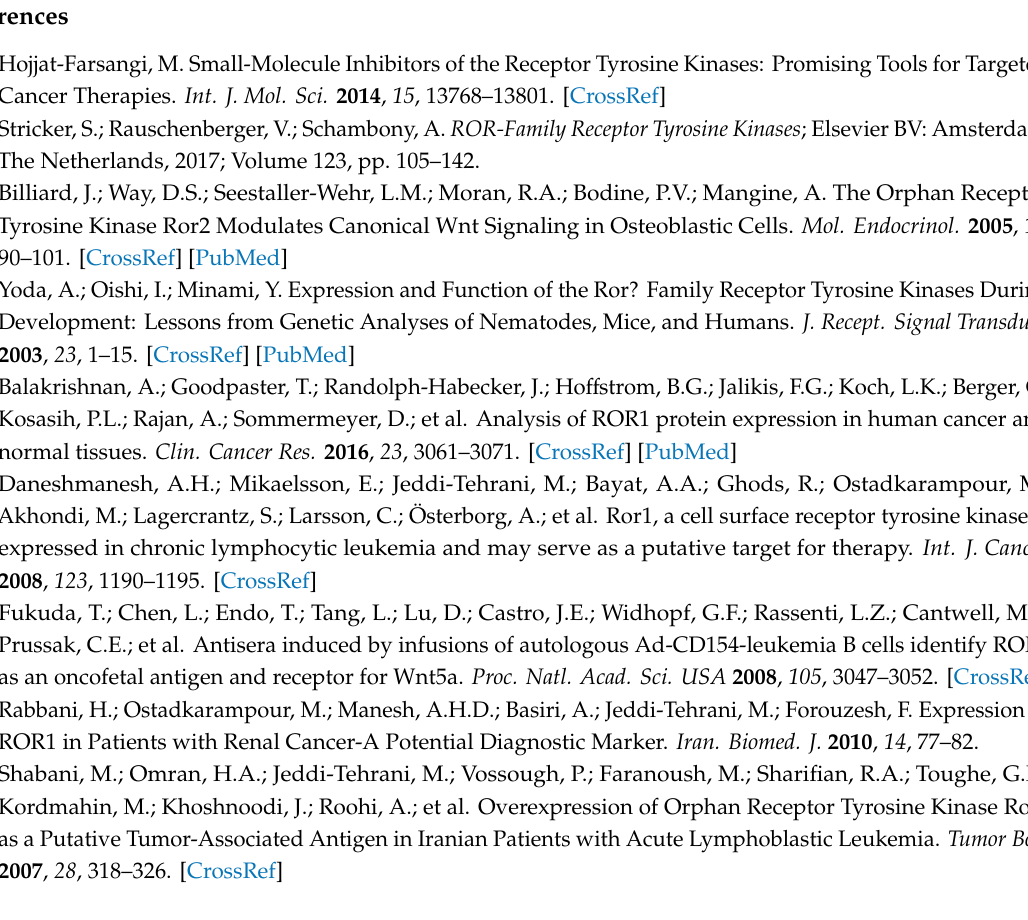
stromal cells (ROR1-) and KAN0441571C. OCI-Ly3 alone (10 5 cells / well) (green line); 10 5 OCI-Ly3 cells + 10 5 HS-5 cells / well (red line); 10 5 HS-5 cells / well (black line). Apoptosis of DLBCL cells were identified by gating for CD19, Figure S5: E ff ects on phosphorylation of ROR1 (pROR1) by venetoclax and KAN0441571C in OCI-LY3 cell line, incubated for 4 h, Figure S6. ROR1 / LRP6 dimerization in OCI-Ly3 cell line. Representative staining images of untreated OCI-Ly3 cell line using anti-ROR1 and LRP6 antibodies in the in situ proximity ligation assay (PLA) (40X) and staining of OCI-Ly3 cells treated with KAN0441571C (2500 and 5000 nM, 6 h). Blue fluorescence (DAPI) was used for counterstaining. Pictures were captured by a fluorescent microscope (40 × ) (Scale bar: 20 µ